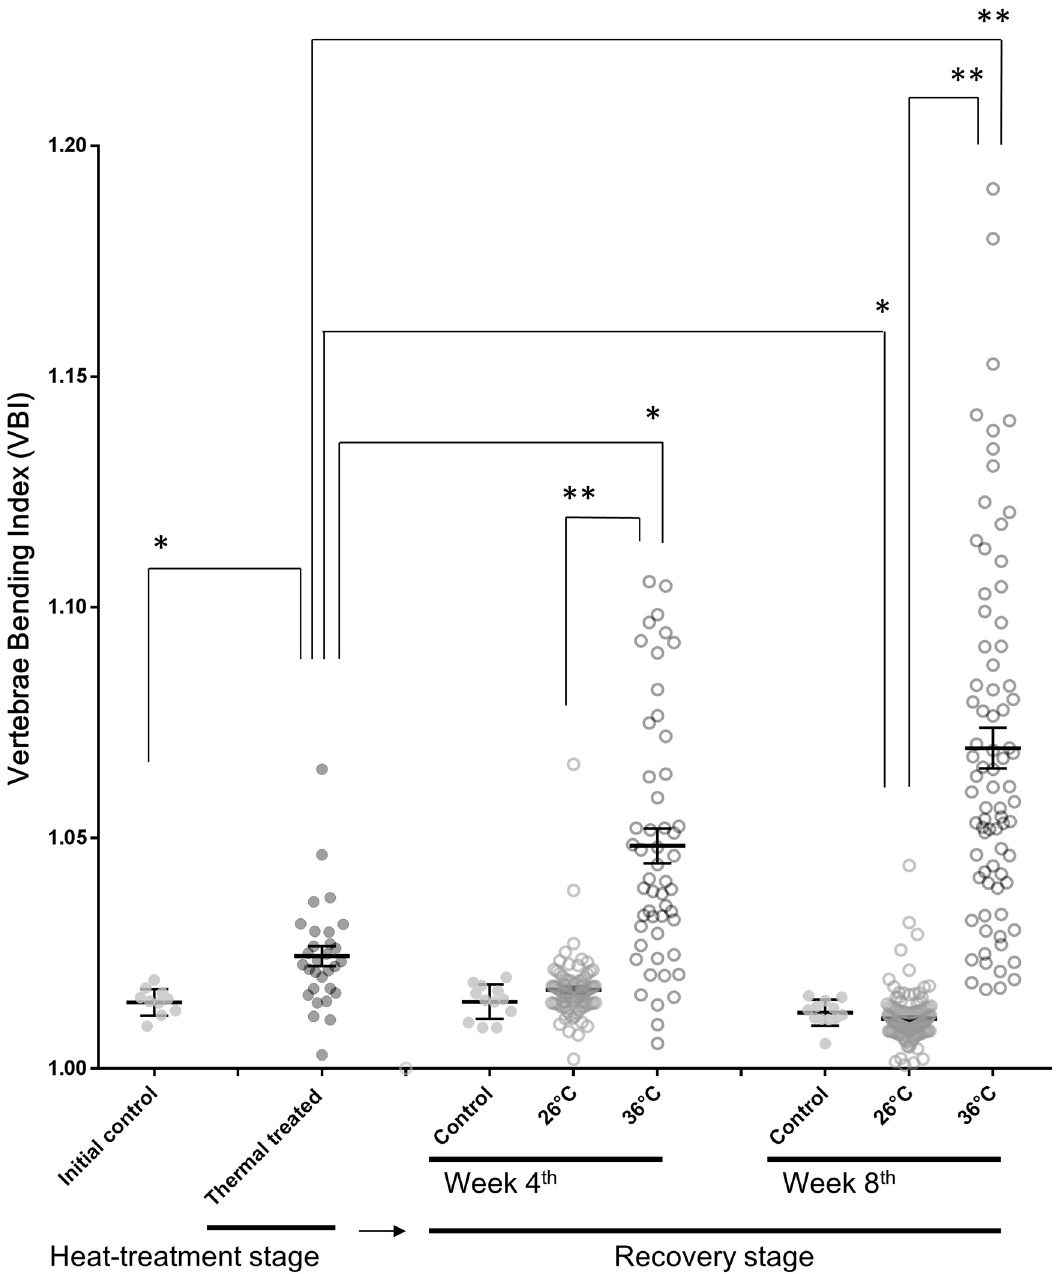
Fig 4. Vertebrae bending index (VBI) in fish kept at 36˚C for 6 weeks (heat-treatment stage), followed by 4 or 8 weeks of 36˚C or 26˚C (recovery stage) in Experiment 2. Control groups were maintained at 26˚C for both the heat-treatment and recovery stages. Mean ± SEM, ( � p <